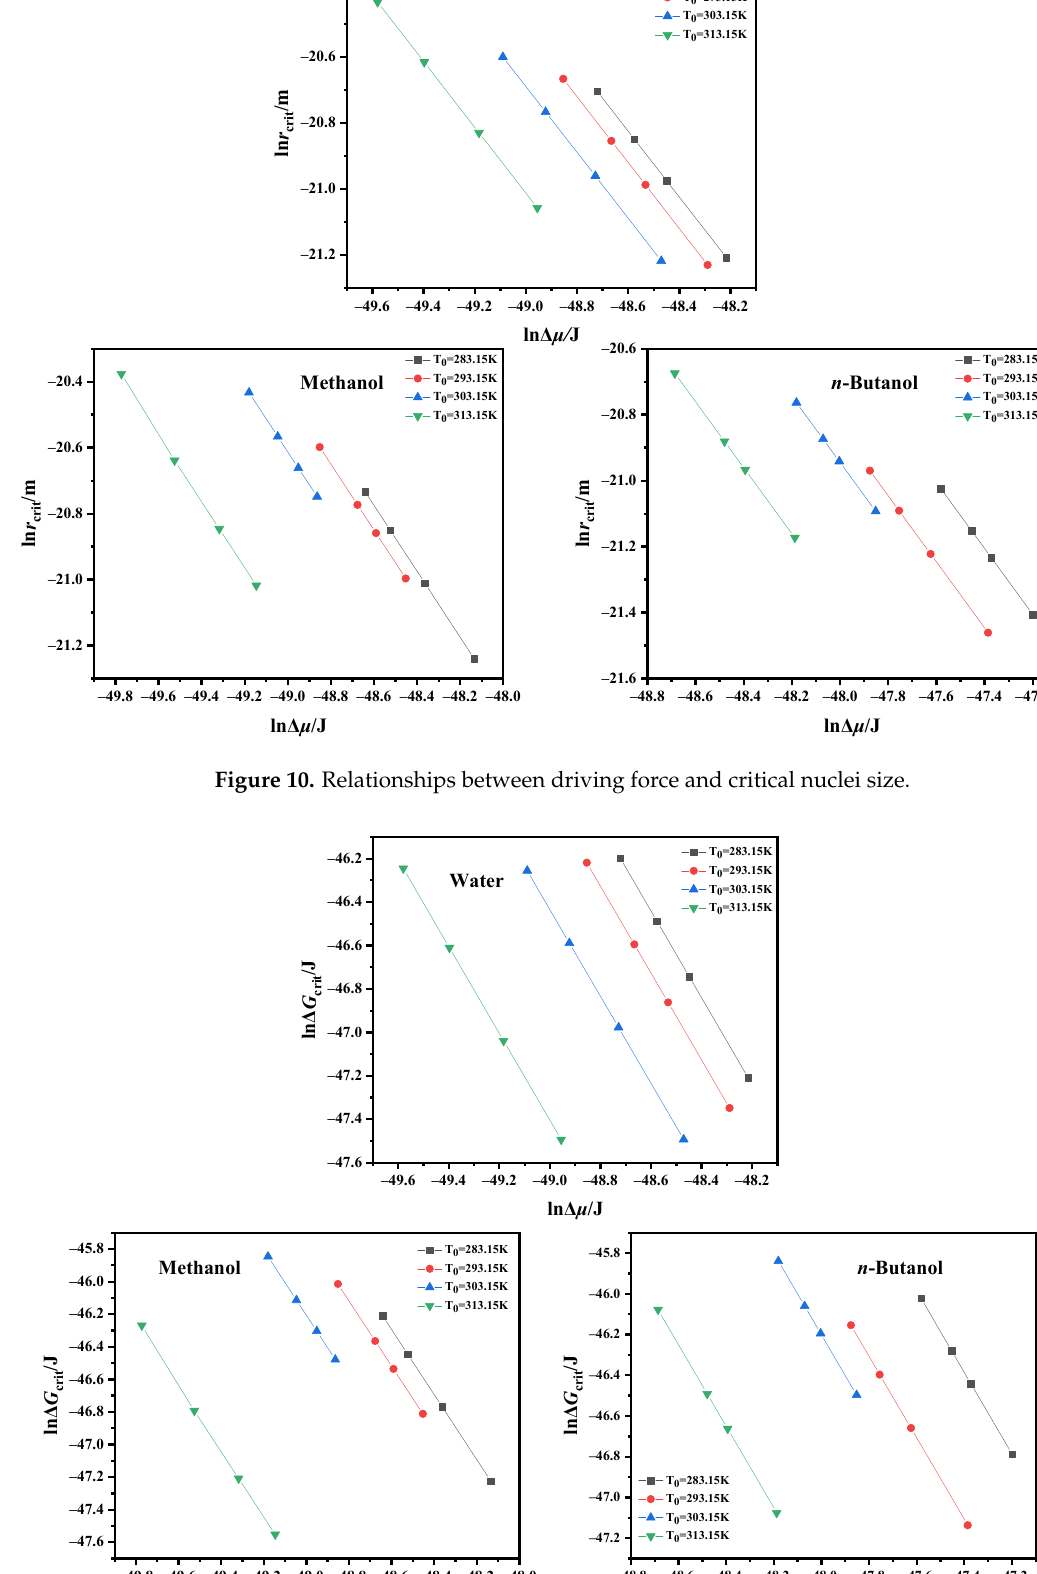
Figure 12. A good linear correlation between r crit and Δ G crit at the same saturation temper- ature was obtained. At different saturation temperatures, the relationship between ln r crit and ln Δ G is nonlinear. This nonlinear relationship may also be due to an important influ- ence of temperature on the tension of the solid–liquid interface.